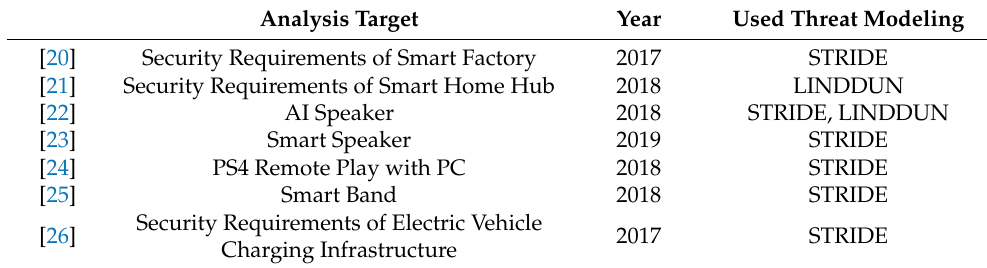
Table 3. List of studies in which vulnerabilities were derived by using threat modeling.